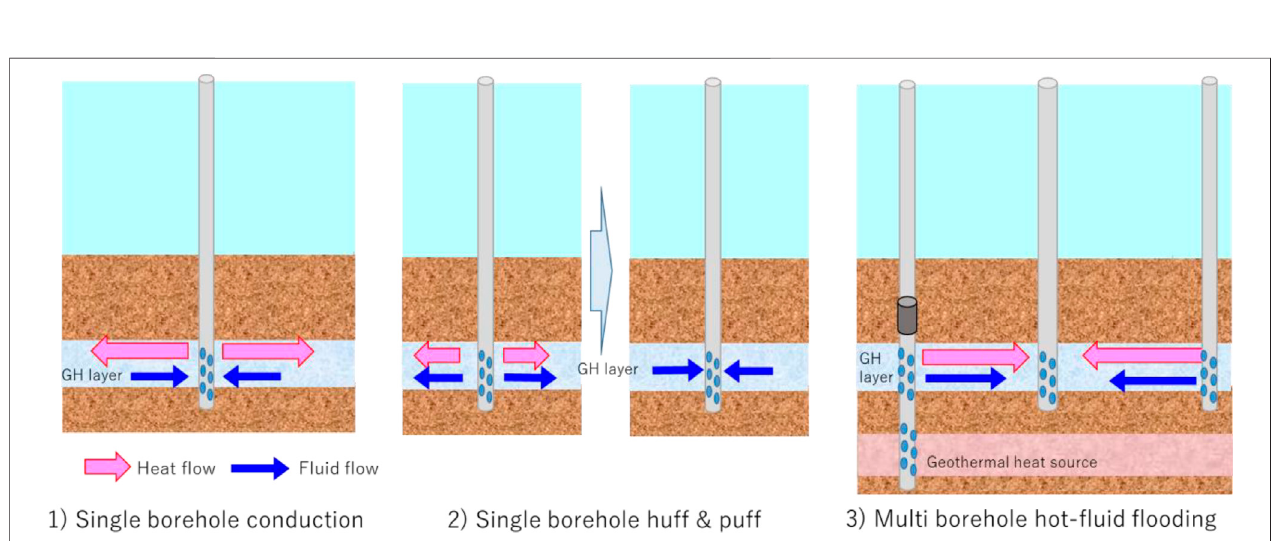
FIGURE 3 | Possible thermal stimulation options with heat and fl uid fl ows involved. To minimize the heat that is not involved into the gas hydrate dissociation is the key to maximize EROI of the depressurization method.